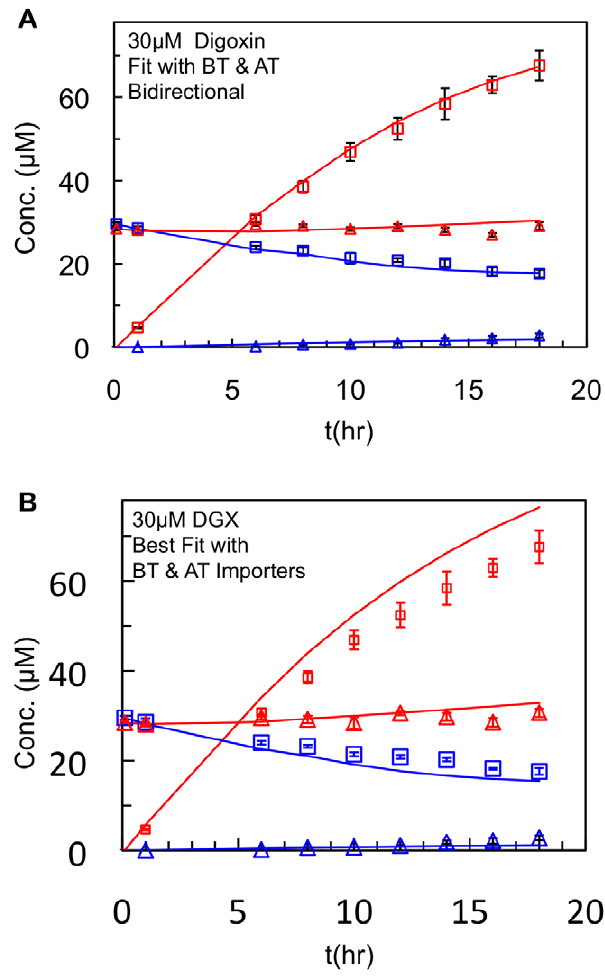
Figure 5. Fits of digoxin data with bidirectional or active importers. Fits of all the digoxin data with the assumption that the basolateral and apical transporters are bidirectional, Fig. 5A , or are active importers, Fig. 5B . The best fits for each mechanism are shown just for the 30 mM digoxin example, which is representative.